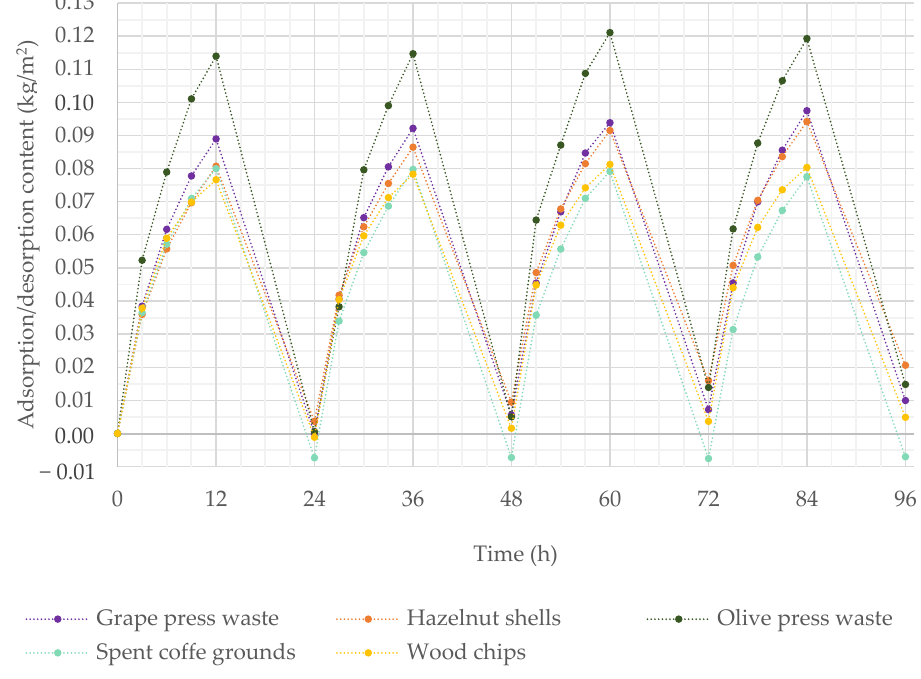
Figure 8. Moisture adsorption/desorption content for four cycles between 50% and 75% RH. Table 7. MBV of analysed bio-wastes classified according to Rode et al. [49].